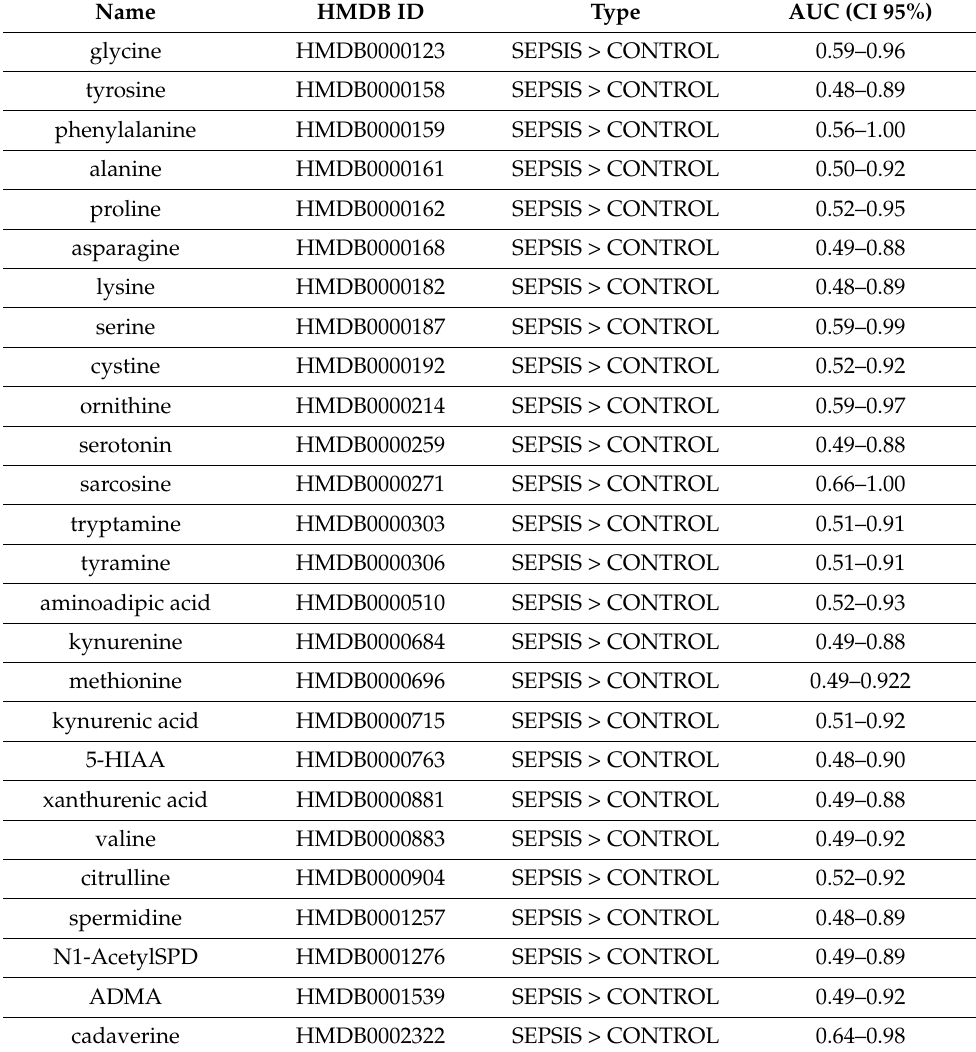
Table 3. Relevant metabolites for blood samples. SEPSIS > CTRL indicates that the mean in the EOS group is higher than in the control group. HMDB ID: identifier used in the Human Metabolome Database. AUC (CI 95%): confidence interval at the level of 95% of the area under the receiver operating characteristic (ROC)